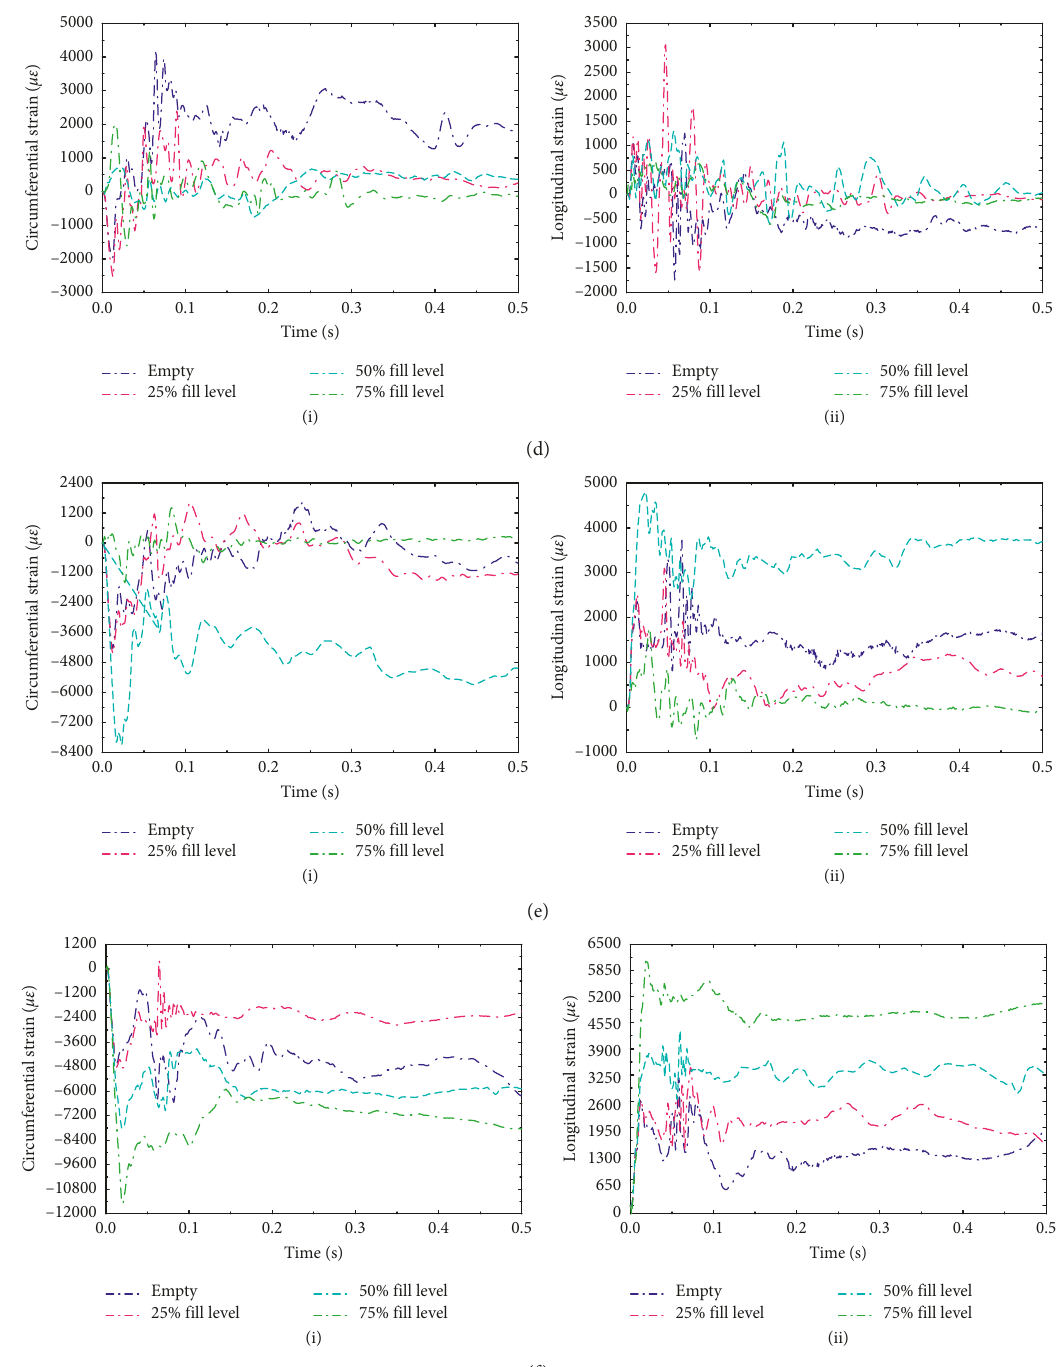
Figure 21: Comparison of circumferential strain and longitudinal strain. (a) 1 st wall: (i) circumferential strain; (ii) longitudinal strain. (b) 2 nd wall: (i) circumferential strain; (ii) longitudinal strain. (c) 3 rd wall: (i) circumferential strain; (ii) longitudinal strain. (d) 4 th wall: (i) circumferential strain; (ii) longitudinal strain. (e) 6 th wall: (i) circumferential strain; (ii) longitudinal strain. (f) 7 th wall: (i) circumferential strain; (ii) longitudinal